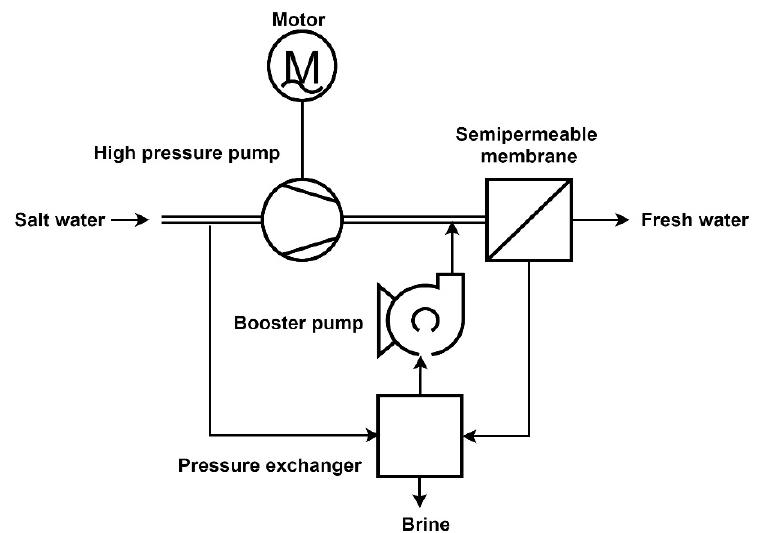
Figure 5. Schematic diagram of an RO desalination unit with an energy recovery system, amended from [47] .